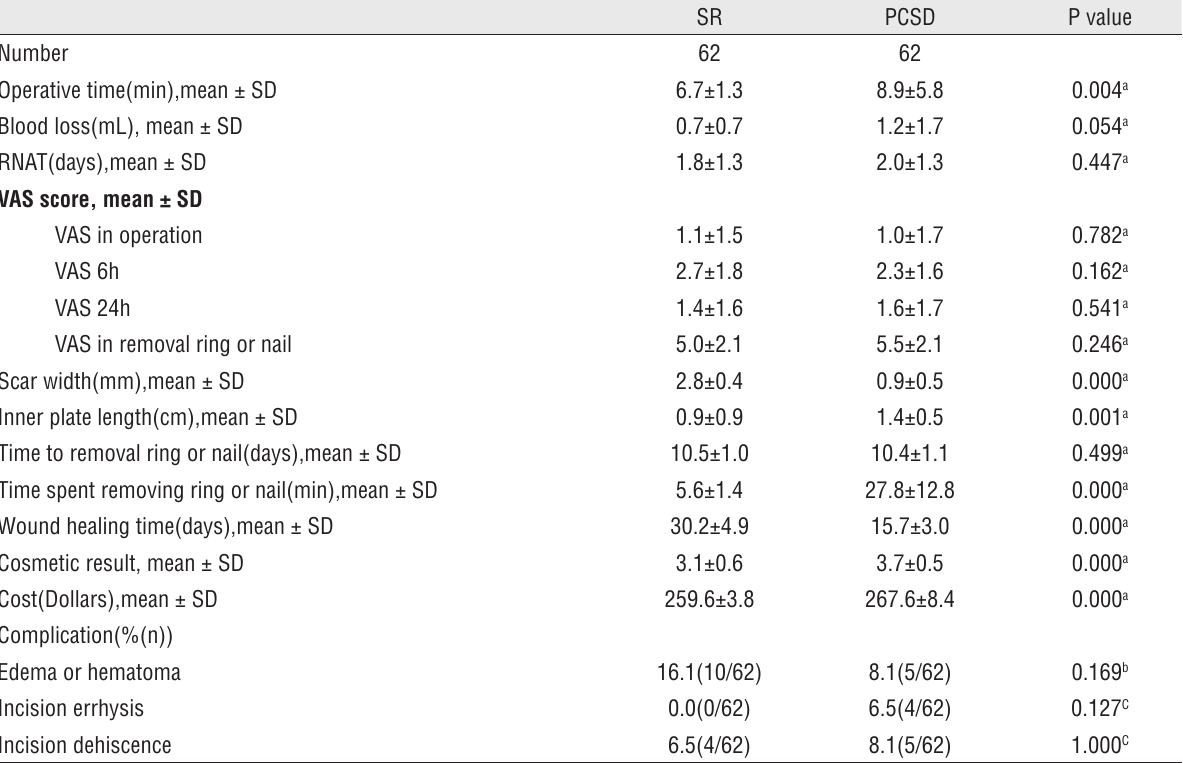
Table 2 - Intraoperative and postoperative